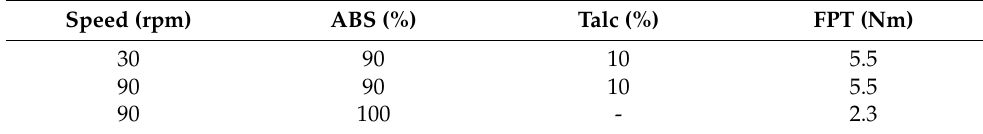
Table 4. ABS/talc composites’ composition and fusion percolation threshold